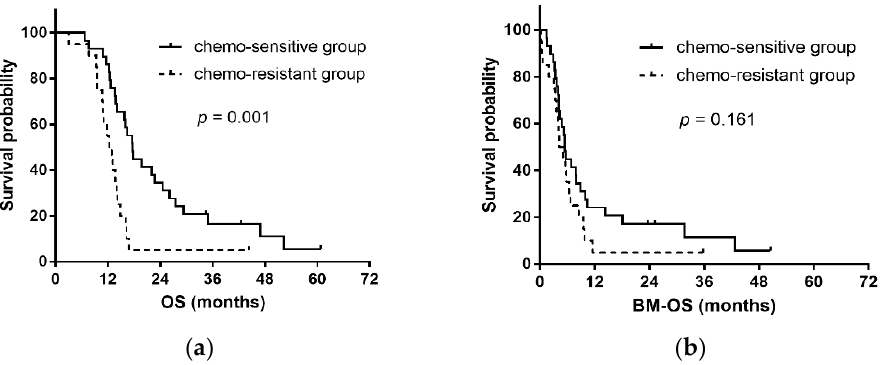
Figure 4. Kaplan–Meier curves for overall survival and survival time after BM in patients with extracranial progression. ( a ) Overall survival; ( b ) Survival time after BM. BM: brain metastasis.